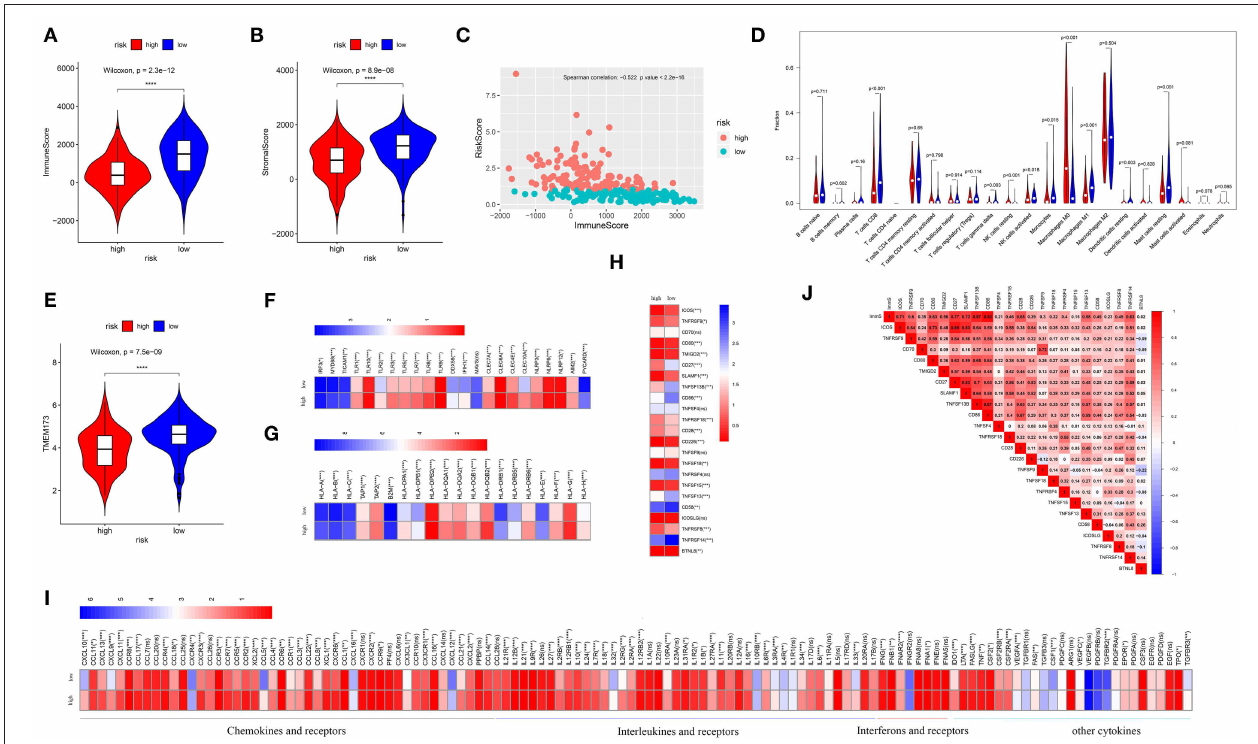
FIGURE 4 | Analysis of immune infiltration in the TCGA dataset. Comparison of the immune scores (A) and stromal scores (B) between high- and low-risk patients. (C) Spearman’s correlation of risk scores with the immune scores. (D) Comparison of 22 types of immune cells in high- and low-risk patients. (E) Comparison of the TMEM173, the initiation molecule of innate immunity between high- and low-risk patients. Comparison of the other molecules of innate immunity (F) , major histocompatibility complex (MHC) molecules (G) , and immune-stimulating molecules (H) , and cytokines (I) between high- and low-risk patients. Low-risk patients exhibited high expression of most of these molecules. Relationships of immune infiltration (immune scores) and immune-stimulating molecules (J) . Immune infiltration was positively correlated with most immune-stimulating molecules. ImmS represents the immune scores. **** p < 0.0001; *** p < 0.001; **0.001 < p < 0.01; *0.01 < p < 0.05; ns (not significant), p >